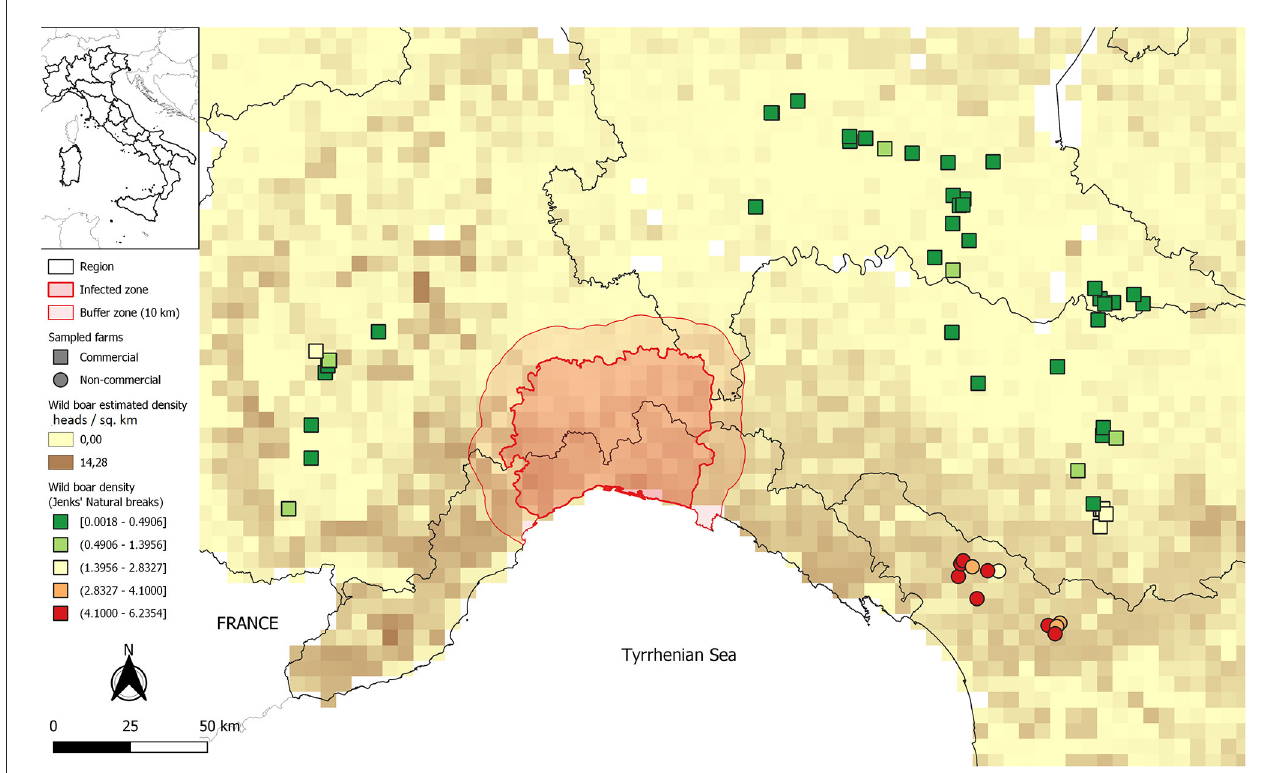
FIGURE1 Geographic distribution of visited 72 pig farms, and of the population density of wild boars in Italy. Commercial farms are identified by squares. Non-commercial and small commercial farms in north-western Tuscany are identified by circles. Farm location colour is based on Jenks natural breaks classification method, of all farm types combined, to better visualize variations in wild boar density. The infected area for ASF (4) is